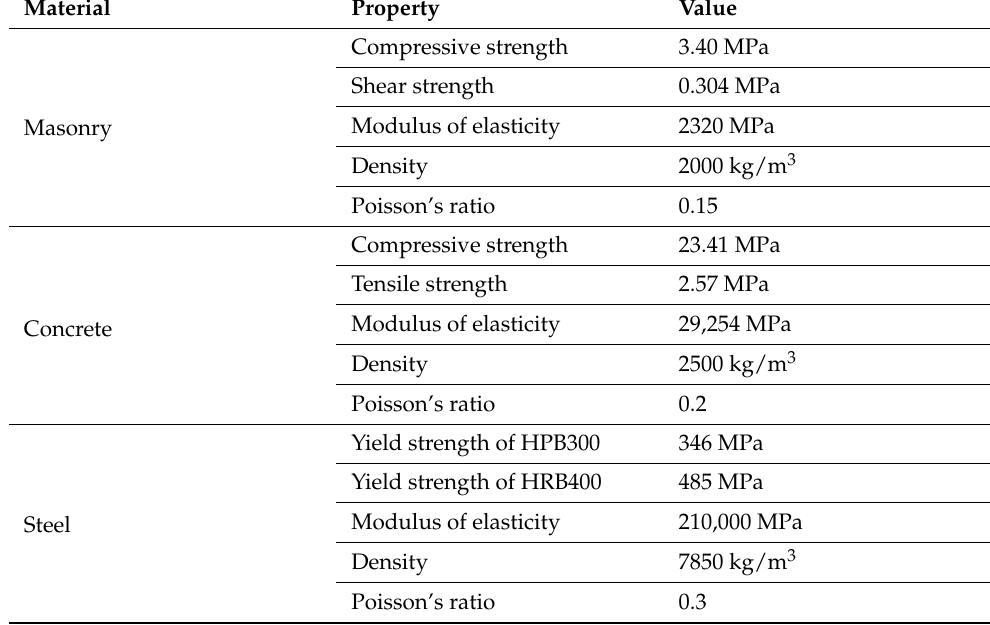
Table 2. Mechanical properties of